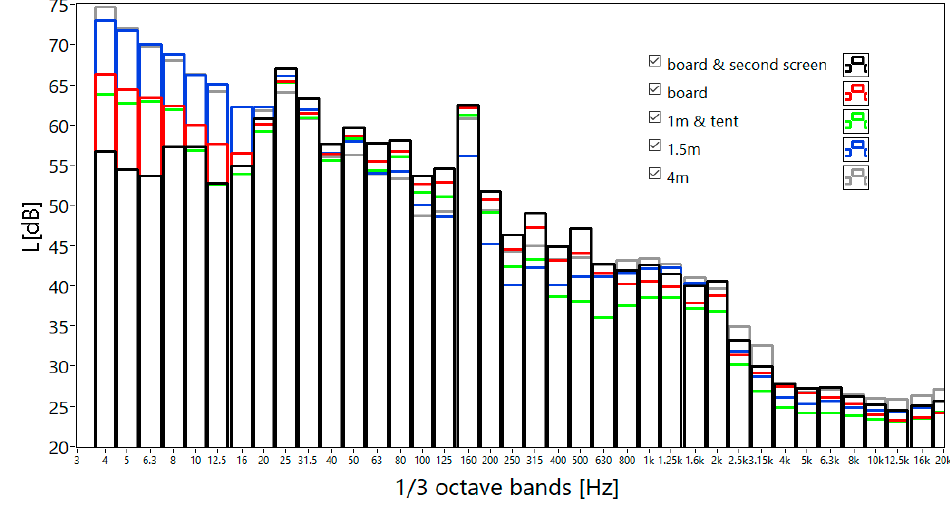
Figure 7. Ventilation shaft noise. One-third octave spectrum—average wind speed 5.0 m/s.